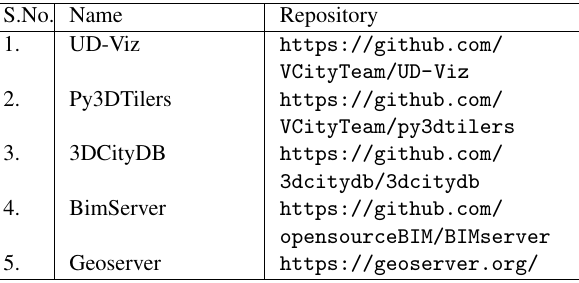
Table 1. Repositories of the open-source components